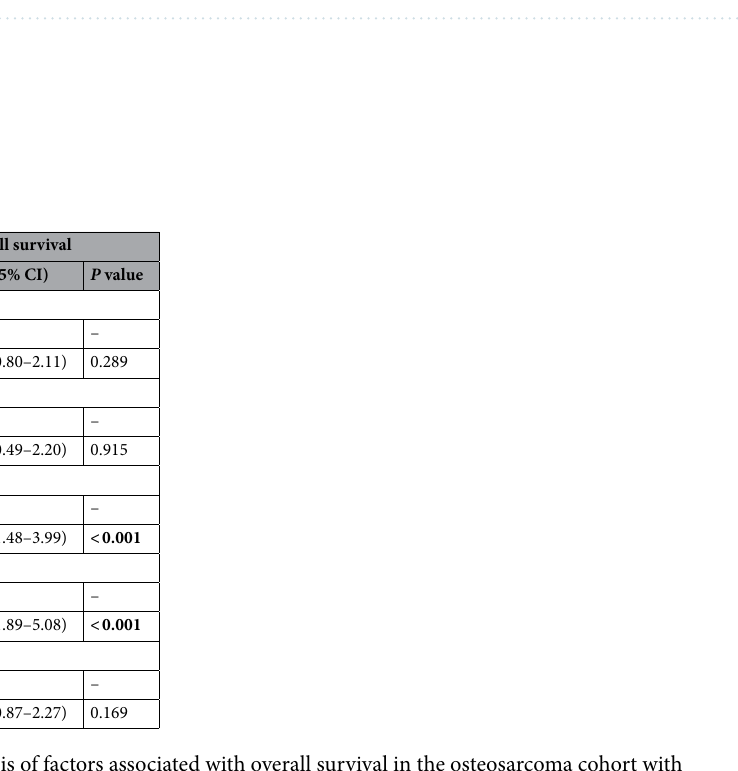
Table 2. Patient survival analysis (N = 119). P values were calculated using the log-rank test. P values < 0.05 shown in bold.